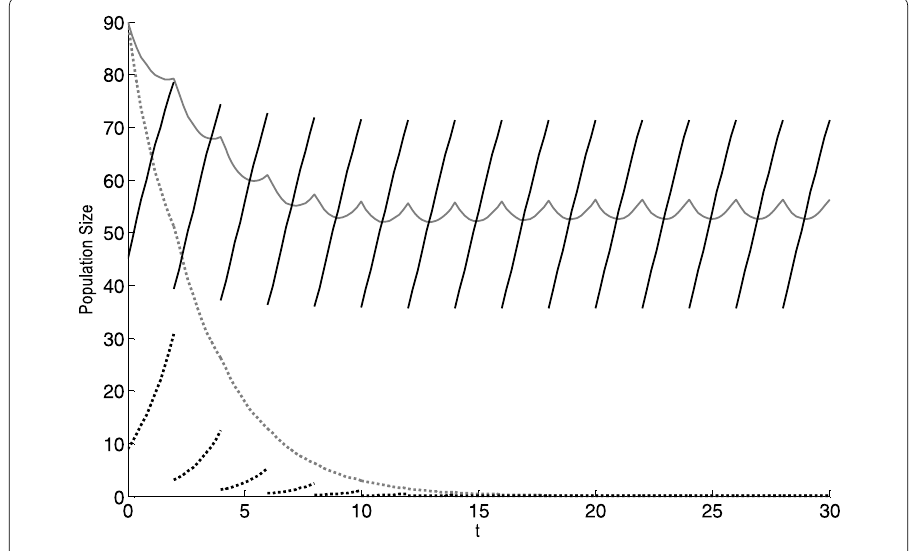
Figure 1 The dynamics of rodent population in model (5) and